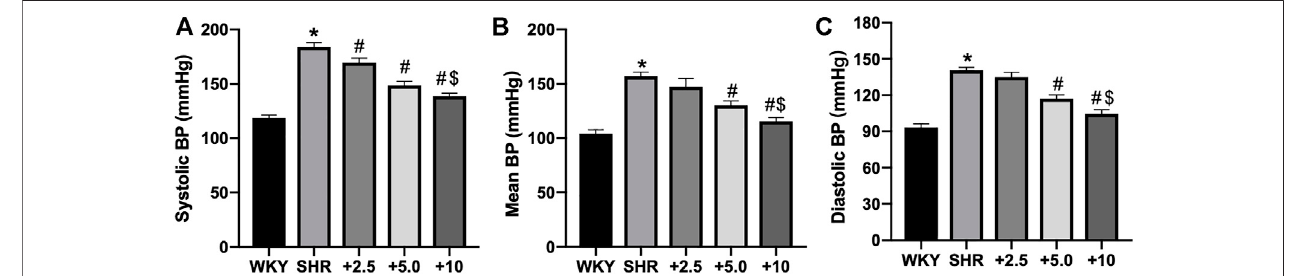
FIGURE 3 | Bisoprolol administration dose-dependently reduces systemic BPs in SHRs. Male SHRs at the age of 8 – 12 weeks old fed with normal diet received bisoprolol administration (2.5, 5.0, 10 mg/kg/day) in drinking water for 10 weeks. BP was measured by radio telemetry, as described in Materials and Methods. Wistar rats served as control. (A) Systolic BP, (B) mean BP and (C) diastolic BP were analyzed. Quantitative results are expressed as mean ± SEM. N is 10 – 15 in each group. * p < 0.05 vs. WKY rats. # p < 0.05 vs. SHRs. $ p < 0.05 vs. 5.0 mg/kg/day bisoprolol